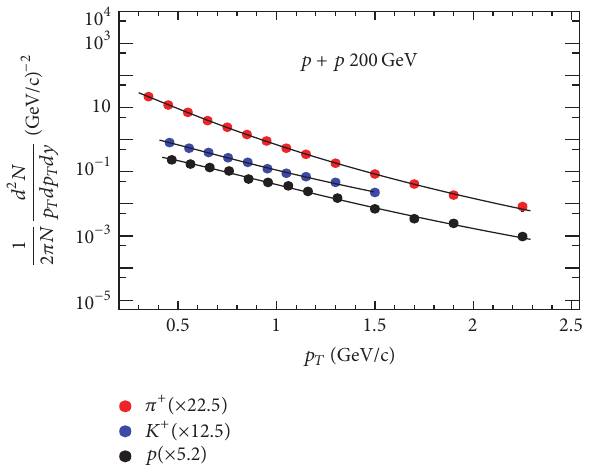
Figure 13: Fitting of invariant 𝑝 𝑇 spectra with Tsallis distribution using (7) for 𝜋 + [21], 𝐾 + [21], and 𝑝 [21] in 𝑝 + 𝑝 collisions at √𝑠 NN = 200 GeV. Symbols represent the data points and line is the fit function.